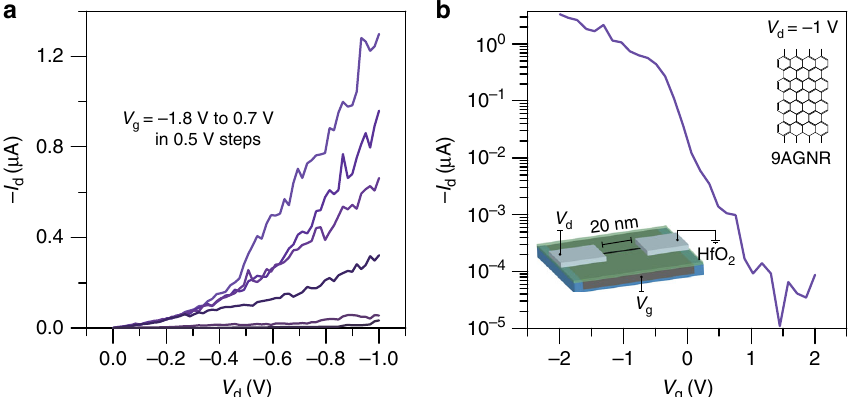
Fig. 5 Transport characteristics of a scaled, high-performance 9AGNRFET at room temperature. a I d − V d characteristics of the scaled 9AGNRFET. b I d − V g of the devices show high I on > 1 μ A for a 0.95 nm wide 9AGNR and high I on /I off ~ 10 5 . Inset : scaled 9AGNRFET